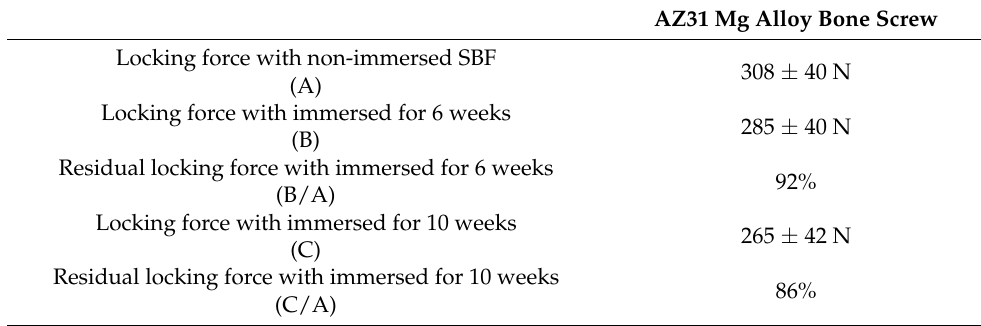
Table 4. Locking force of the AZ31 Mg alloy bone